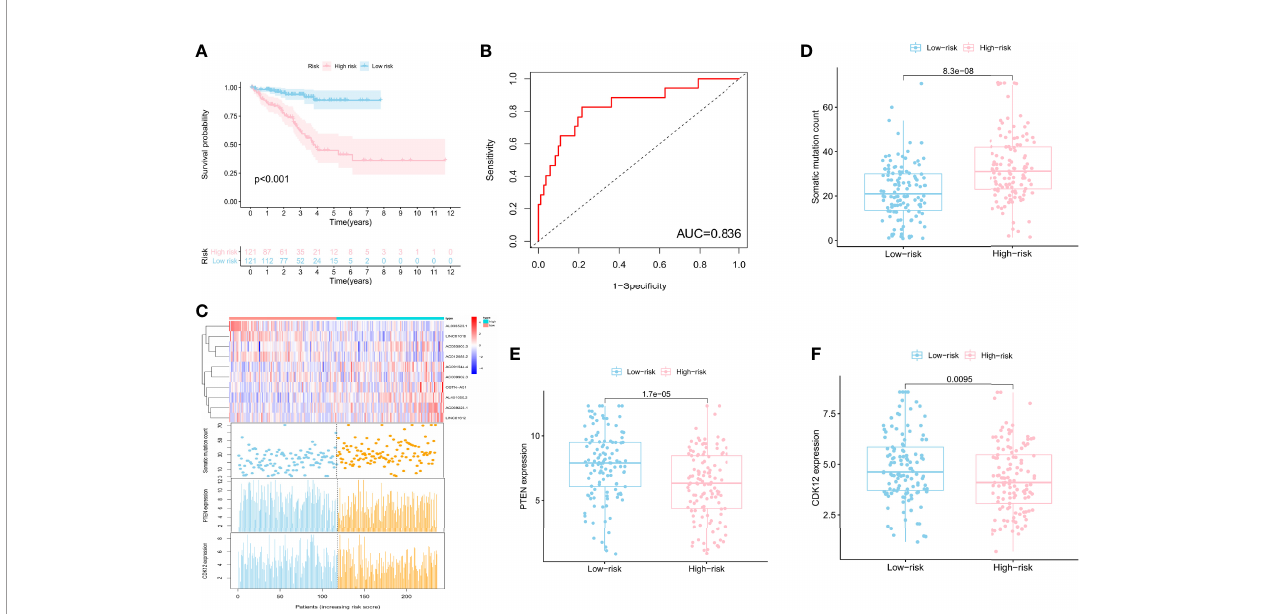
FIGURE 2 | A signature derived from genomic instability-associated lncRNAs for biochemical recurrence in the train set. (A) Kaplan – Meier analysis of biochemical recurrence in patients with low or high risk predicted by the GILncSig in the train set. (B) ROC curve analysis of the GILncSig. (C) lncRNA expression patterns, the distribution of somatic mutation, and PTEN and CDK12 expression with increasing GILncSig score. Somatic mutation count distribution (D) , PTEN expression (E) , and CDK12 expression (F) in the high- and low-risk groups for PCa patients. The blue boxplot represents the high-risk group, and the red boxplot represents the low-risk group.